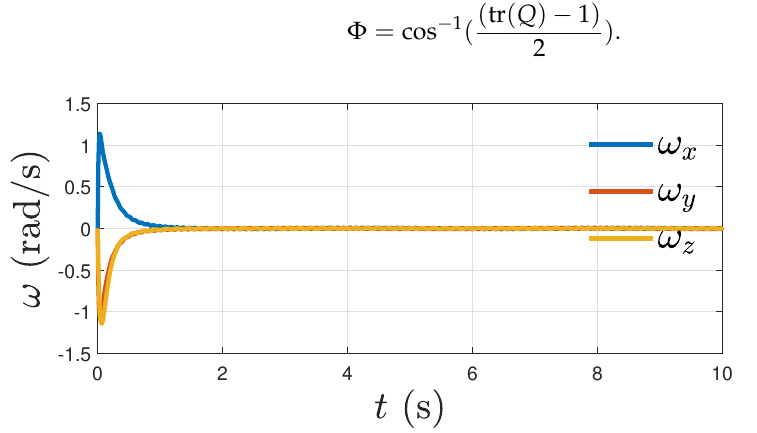
Figure 7. Angular velocity tracking error versus time.